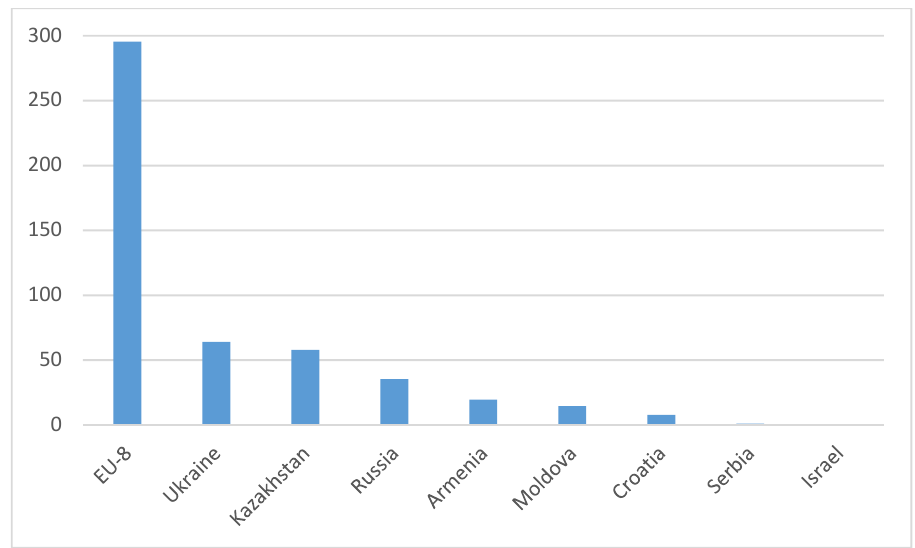
Figure 4. Ratio of post-EU accession root mean square prediction error (RMSPE) to pre-EU accession RMSPE: EU-8 and control countries.